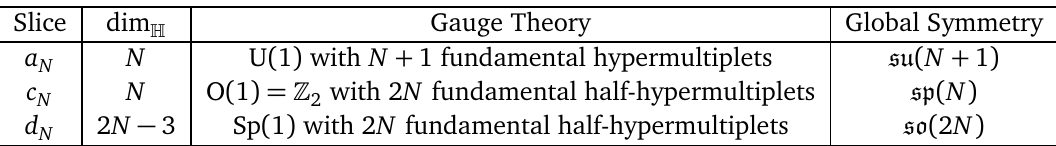
Table 4: List of elementary slices which appear in this paper. These are the closures of the minimal nilpotent orbits of their global symmetry